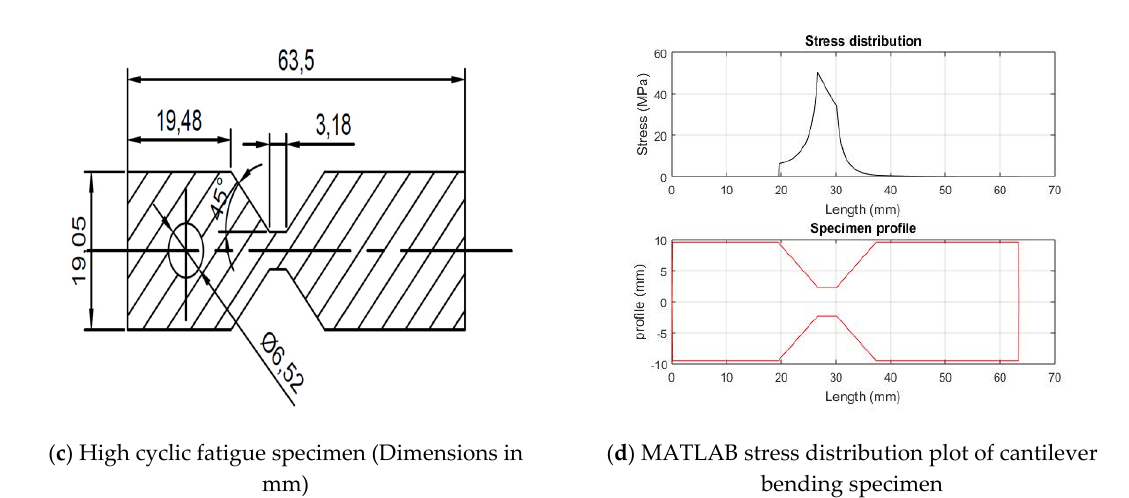
Figure 2. Bending fatigue test using standard samples of A357 aluminum semi solid materials.